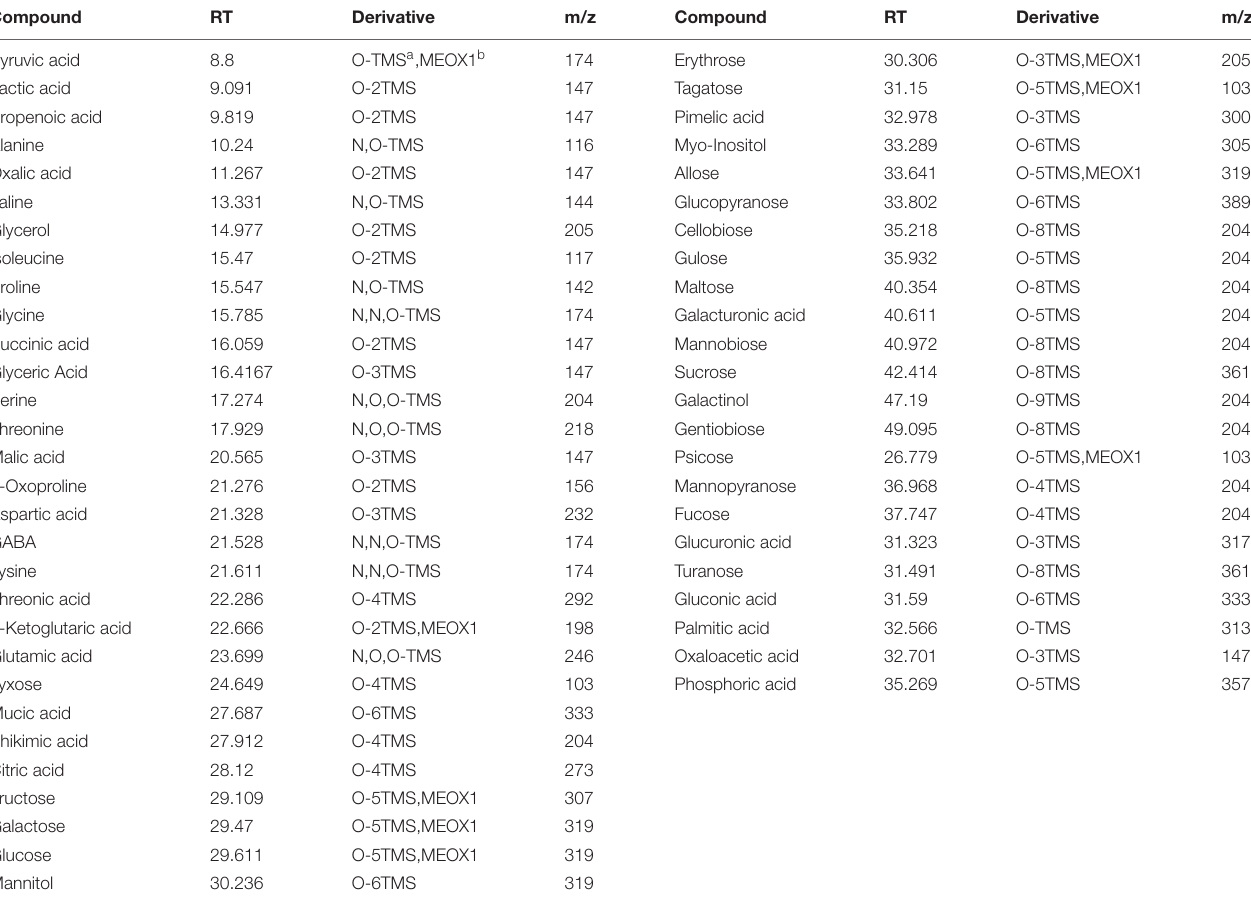
TABLE 1 | Metabolites identified by GC-MS in response to different CO 2 concentrations and temperatures in leaves of bermudagrass at 28 days of treatments.